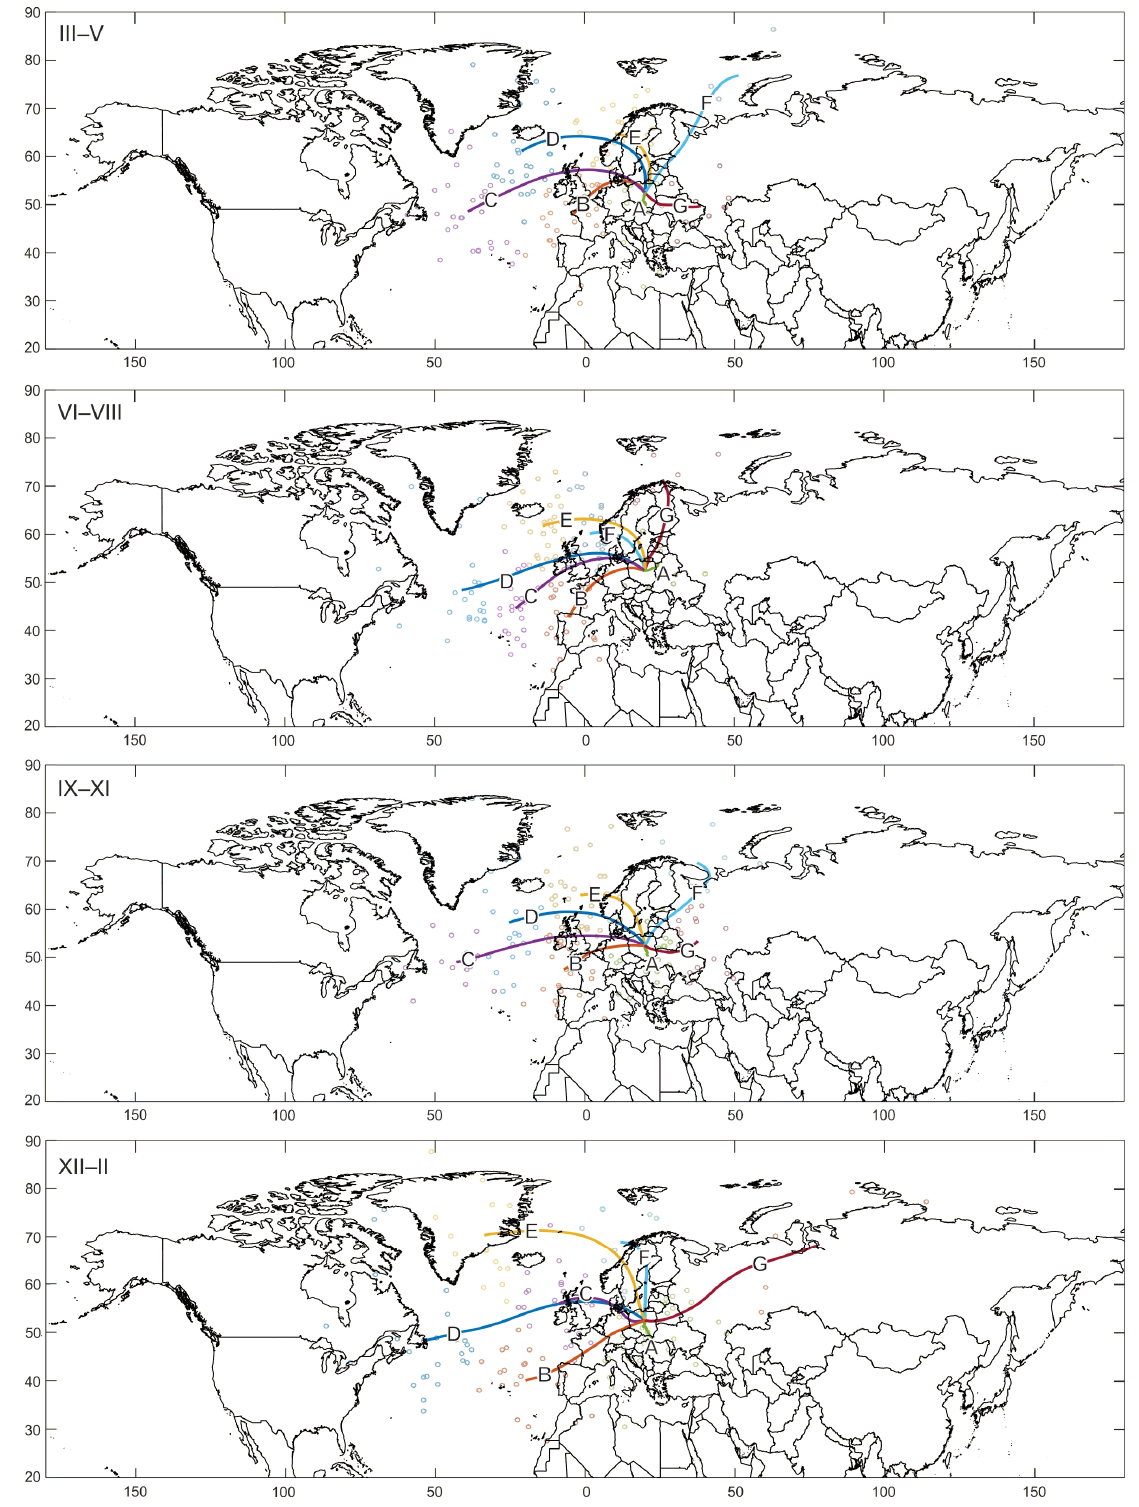
Figure 4. Averaged 72 ‐ h backward trajectories in 7 clusters ending at the grid point 52.5° N, 20° E at 12:00 UTC at 3000 m above ground level, on days with extremely large sums of global solar radiation (above the 0.95 percentile) over Poland, broken down by seasons of the year during the period 1986–2015 and clustered starting points of all backward trajectories on days with extremely large sums of global solar radiation in individual seasons of the year in the period 1986–2015.